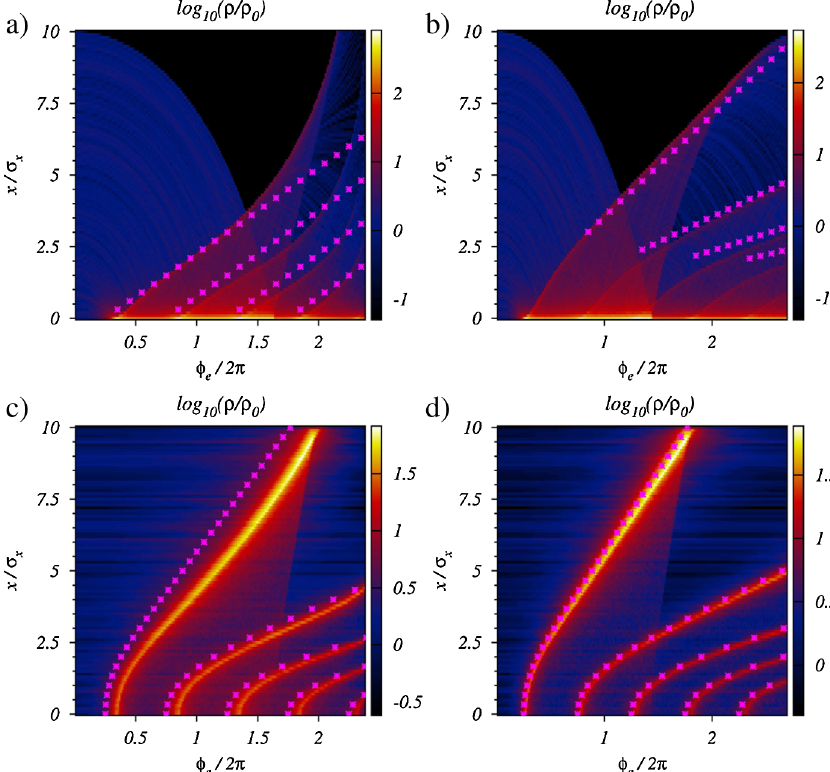
FIG. 4. (Color) Electron density enhancement in the x (cid:2) (cid:4) e plane, at y ¼ 0 , with a Gaussian (left) or uniform longitudinal profile (right) without field (top) and in a dipole (bottom). Note the markers which on top which are obtained by Eq. (8) for (a), and Eq. (6) for (b). On the bottom pictures the markers are from Eq. (10).